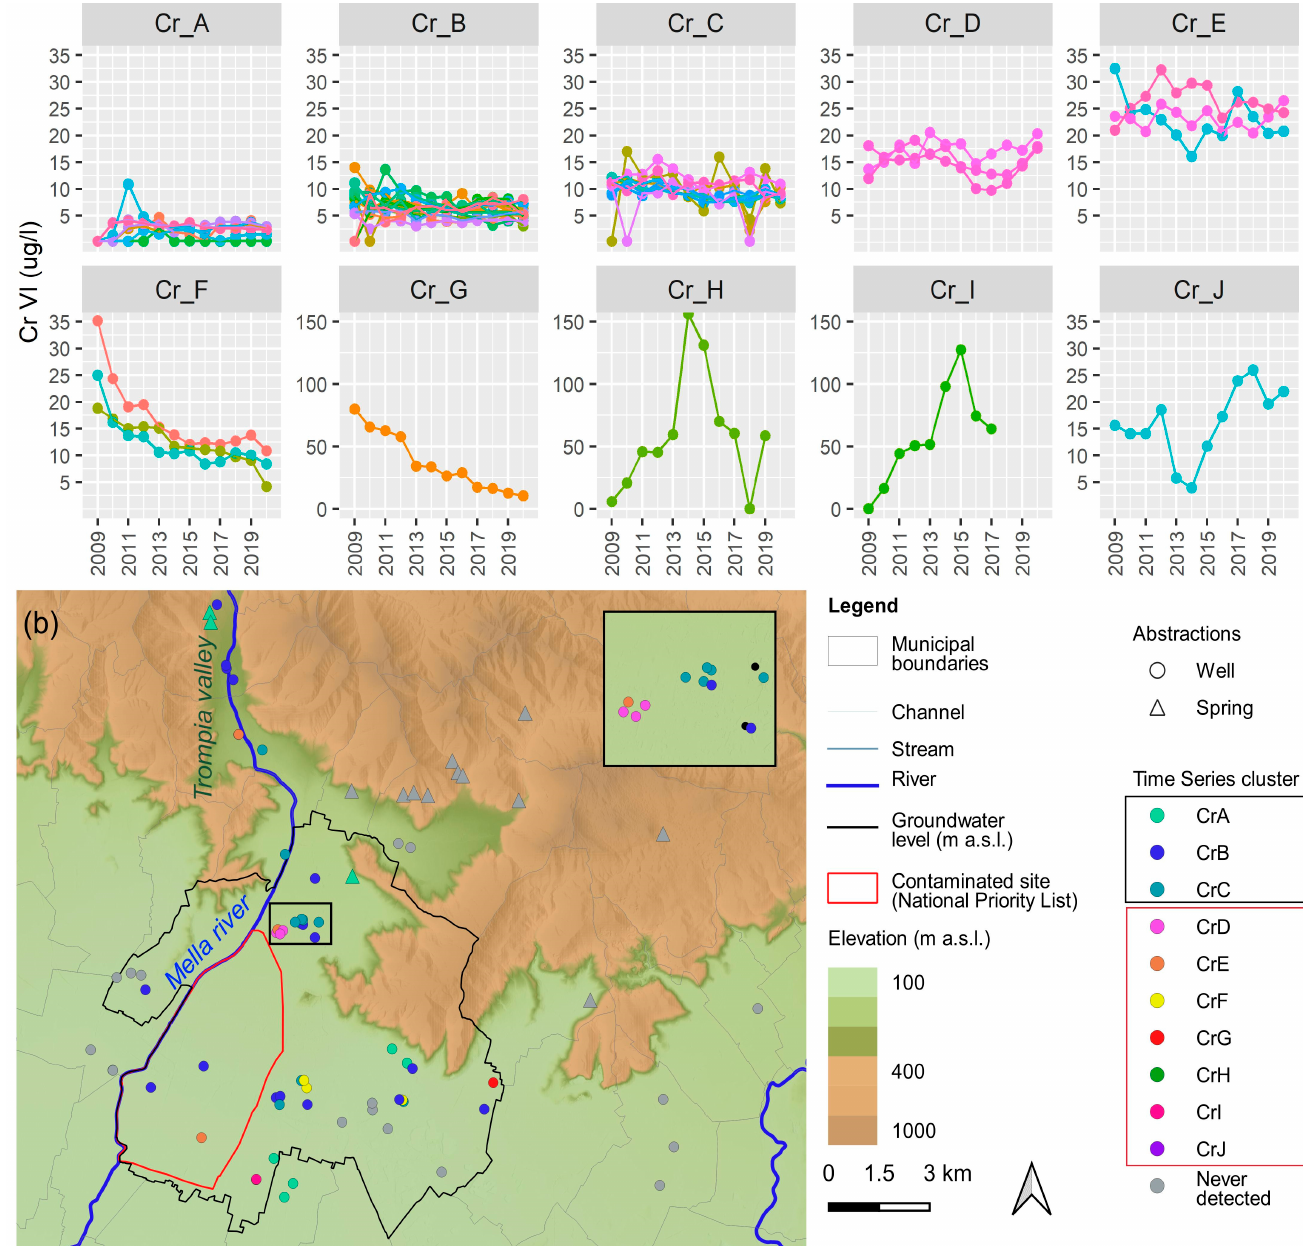
Figure 5. Results of univariate time series cluster analysis on Cr(VI): ( a ) Cr(VI) time profile of the clusters, ( b ) spatial distribution of the clusters, black rectangle in the legend indicates clusters associated with diffuse background contamination, while red rectangle indicates clusters associated with local hotspots.